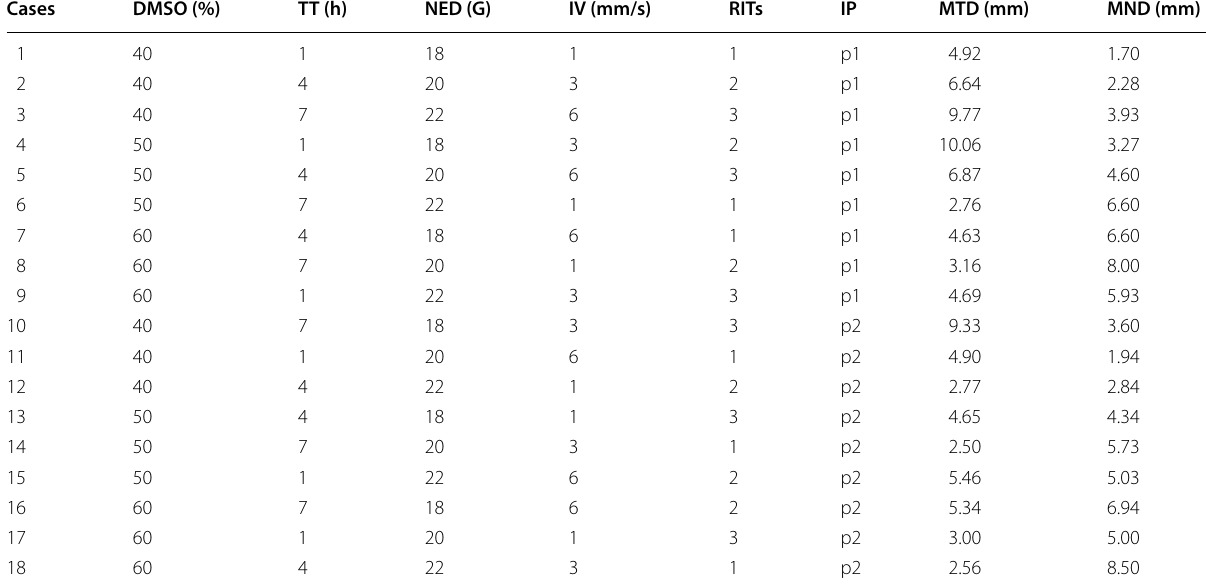
Table 3 Orthogonal test of input parameters and the corresponding results of MTD and MND Cases